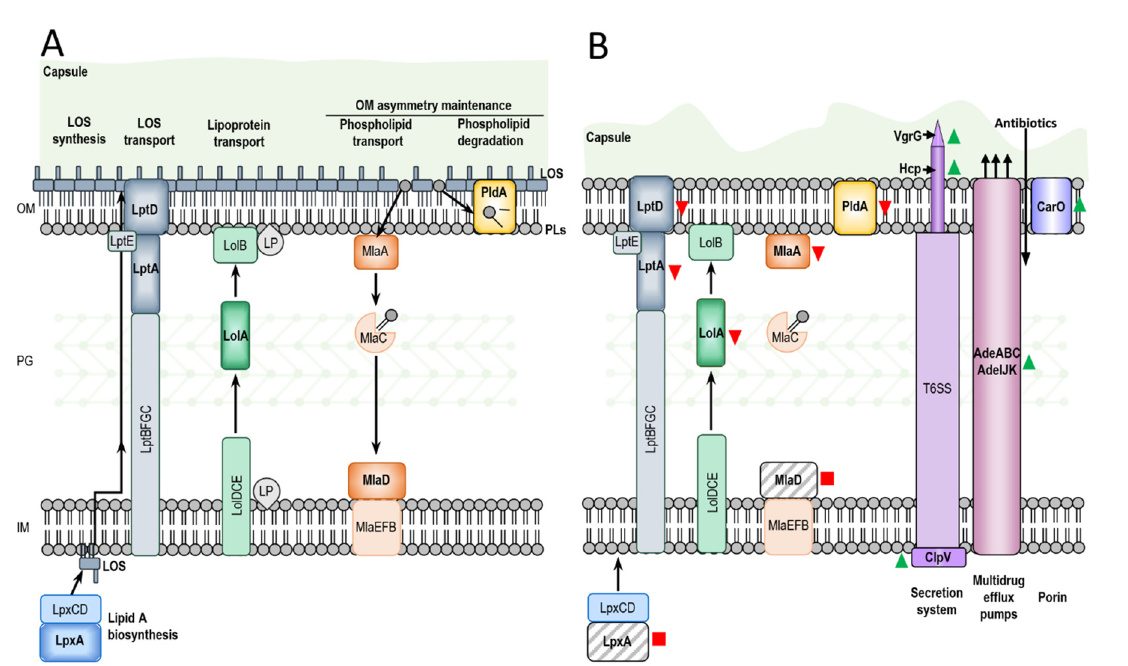
Figure 5. Schematic comparison of Ab-S and Ab-D illustrating a major changes occurring during the dependence process. The A. baumannii envelope consists of the inner membrane (IM), an aqueous periplasm containing a thin layer of peptidoglycan (PG), the outer membrane (OM) and a polysaccharide capsule. In Ab-S ( A ) LpxA catalyzes the first step of lipid A biosynthesis in the cytoplasm, and the completed lipooligosaccharide (LOS) is transported to the cell surface by the Lpt molecular machinery. The Lol system translocate lipoproteins (LP) from IM to innermost leaflet of the OM, and Mla and PldA help establish OM asymmetry, removing wrongly localized phospholipids (PLs) from the outer leaflet of OM. The capsule in Ab-D ( B ) cells is thin with surface imperfections. Ab-D cells exhibit a LOS-deficient phenotype ( B ), where PLs occupy both leaflets of the OM, and lipid A is missing due to the IS disruption of lpxA gene. The lipopolysaccharide transporters LptA and LptD, OM asymmetry-maintaining proteins MlaA, MlaD, and PldA and periplasmic chaperone LolA downregulated in comparison to Ab-S or missing. The VgrG, Hcp and ClpV, components of the type 6 secretion system (T6SS) and several Ade components of the RND-type efflux pumps, as well as the carbapenem susceptibility porin or CarO, were significantly upregulated in Ab-D. Red squares, red arrows pointing down, green arrows pointing up indicate lost, downregulated and upregulated proteins, respectively.